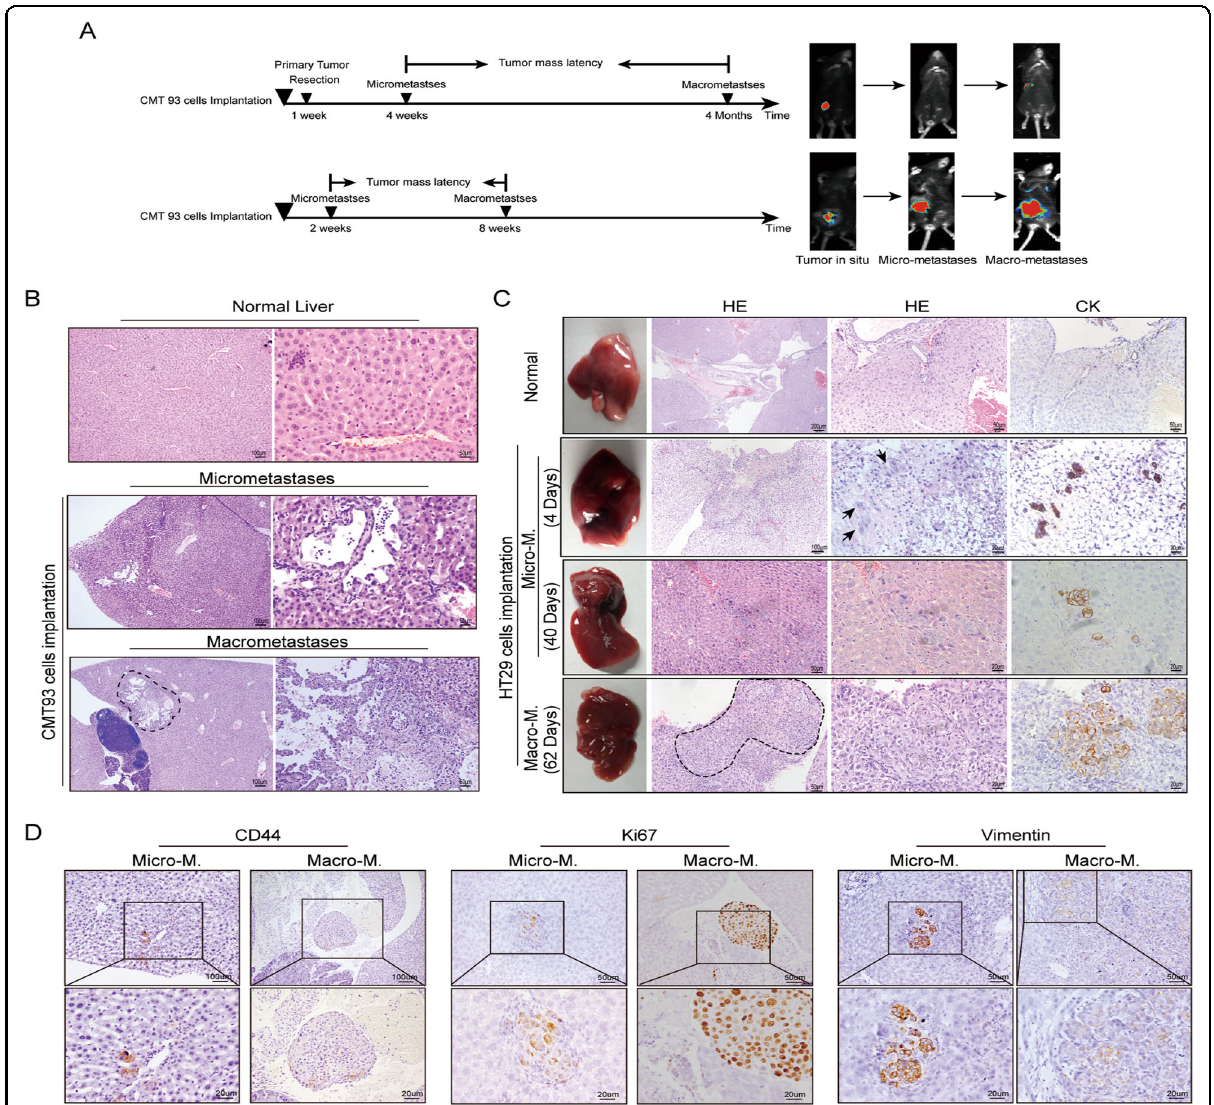
Fig. 1 Construction of CRC metastatic dormant models in mice. A A brief sketch of two animal models of CRC metastasis in C57 mice. B Representative images of liver metastases in different metastatic stages. C Observation of liver metastasis of HT29 cells after injected into spleen of nude mice by HE and immunohistochemistry stained with CK7. D The immunohistochemistry stain of CD44 or Ki67 or Vimentin in liver metastasis of nude mice injected with HT29